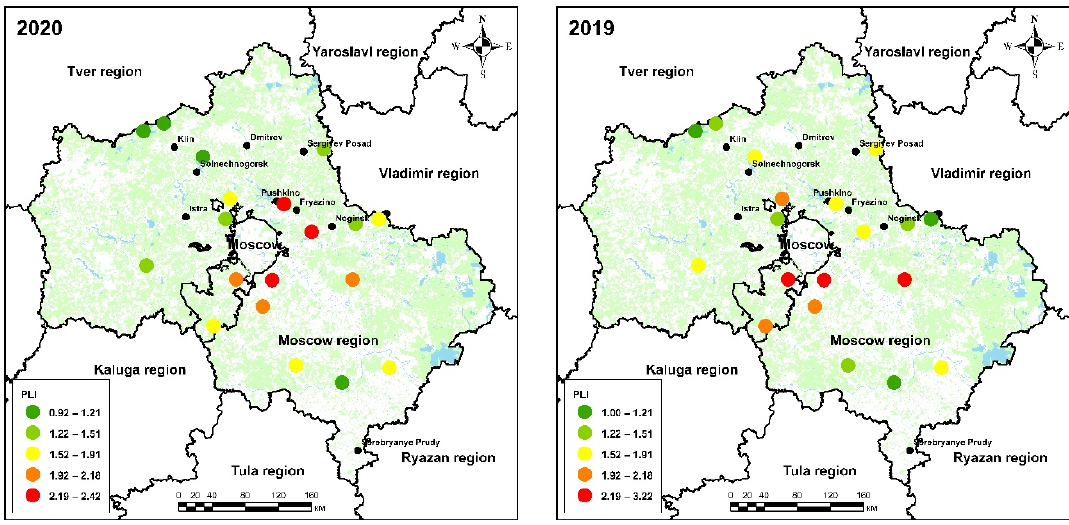
Figure 3. The map of the distribution of PLI values in Moscow region.